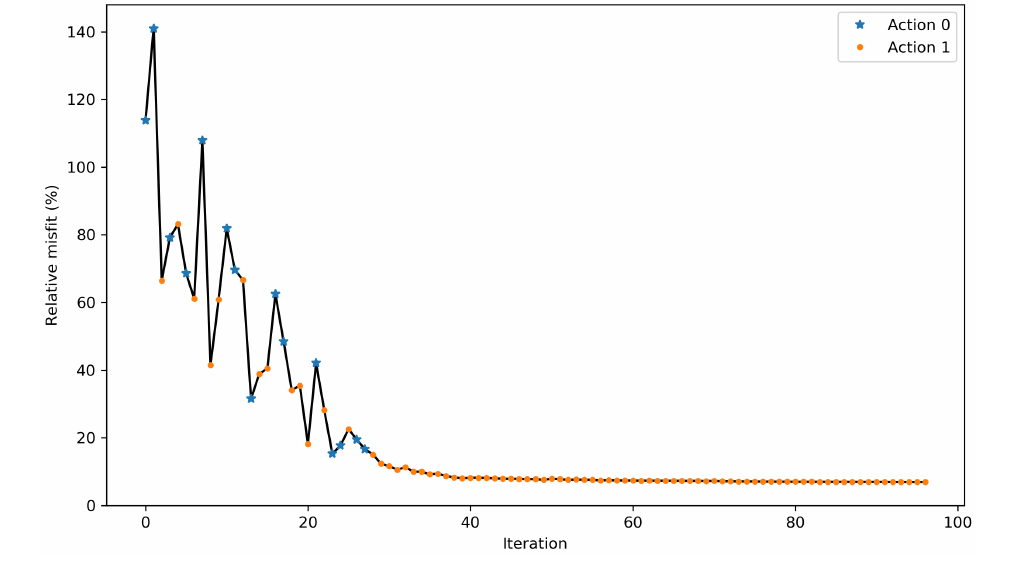
Figure 9. Action execution by the DQN framework in an independent